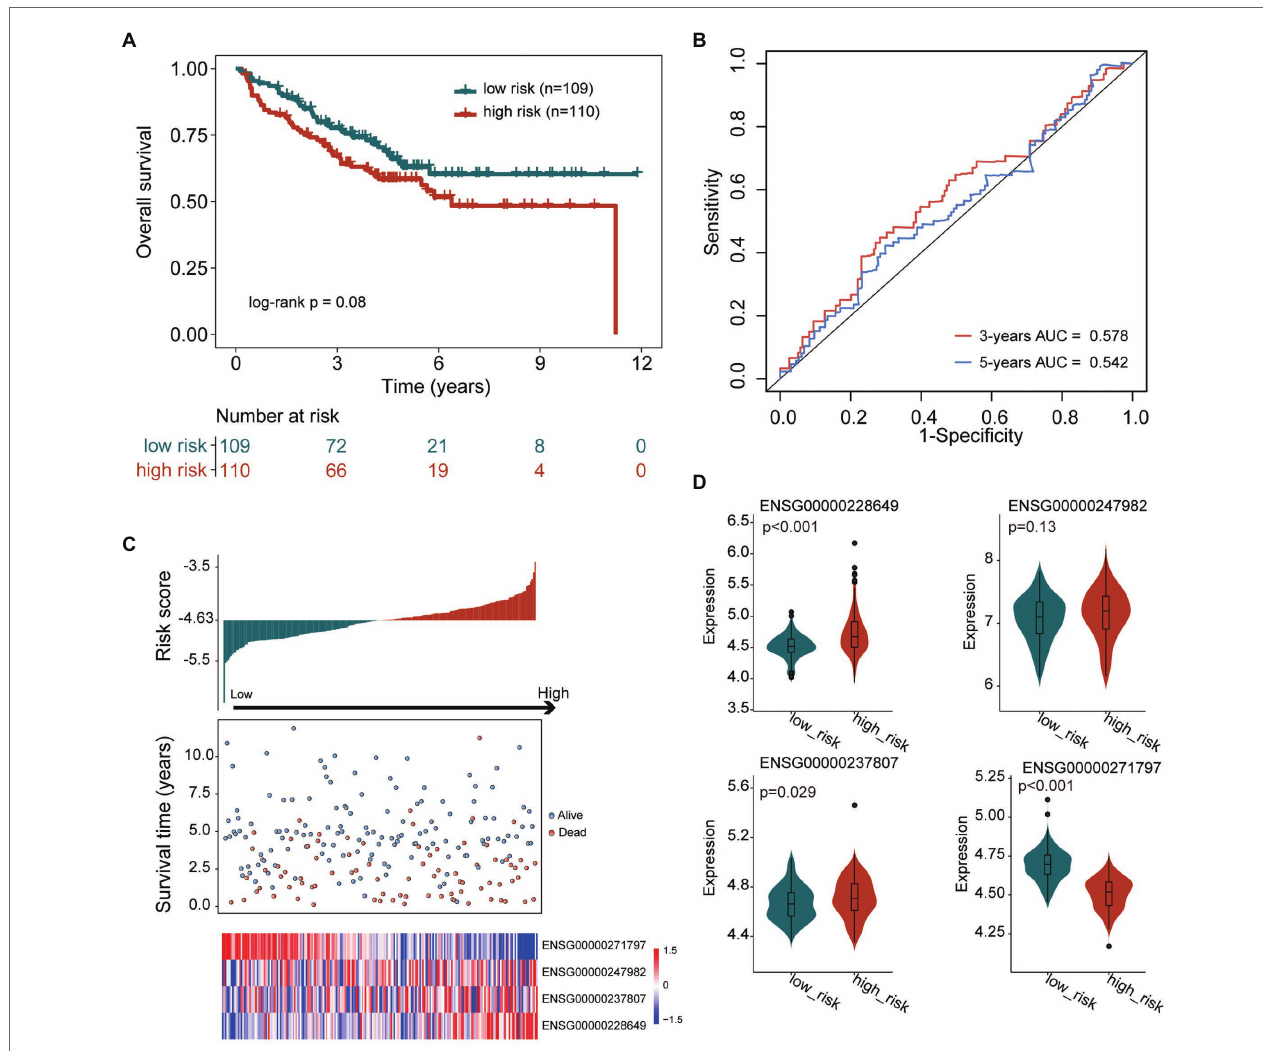
FIGURE 3 | Performance validation of the TIILncSig for predicting overall survival in the GSE17538 cohort. (A) Kaplan-Meier survival curves of overall survival between high- and low-risk groups. (B) The time-dependent ROC analysis of the sensitivity and specificity for survival prediction by the TIILncSig. (C) The risk score distribution, survival status, and expression pattern of the TIILncSig. (D) Boxplot representing expression differences of lncRNAs between high- and low-risk